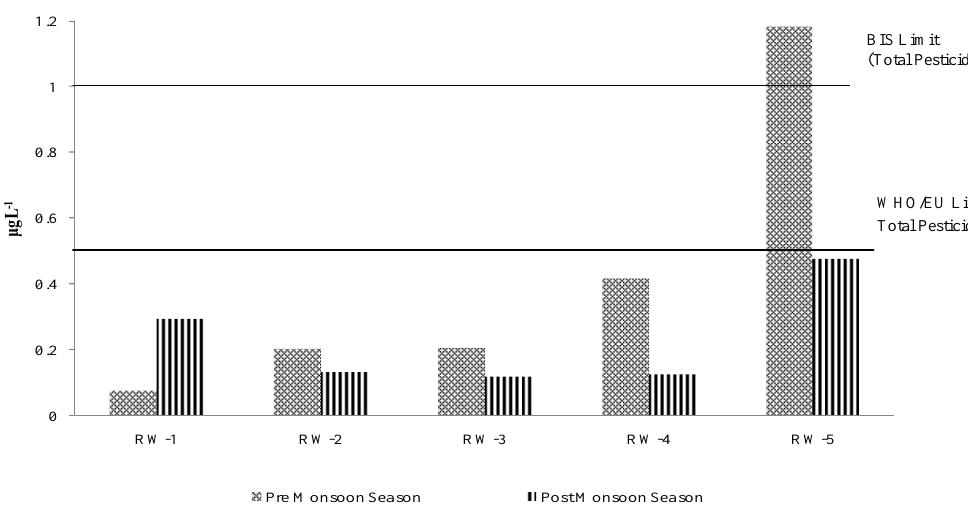
Figure 6. Comparison of Ranney well water quality with respect to various limits.